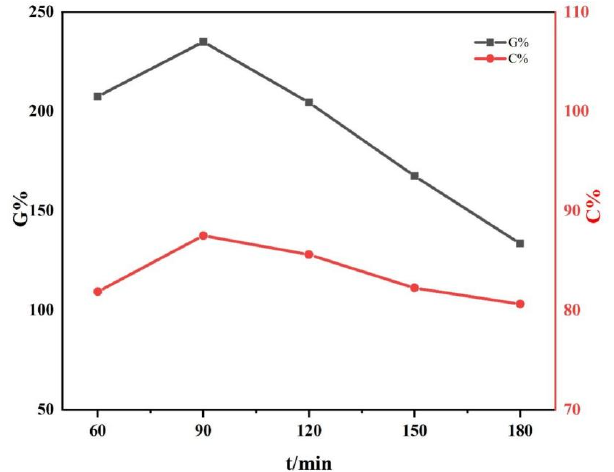
Figure 2. Grafting rate and monomer conversion rate of CDA − g − PLLA at different reaction times by reacting L-LA/CDA at a feeding mass ratio of 4:1 at 130 °C.